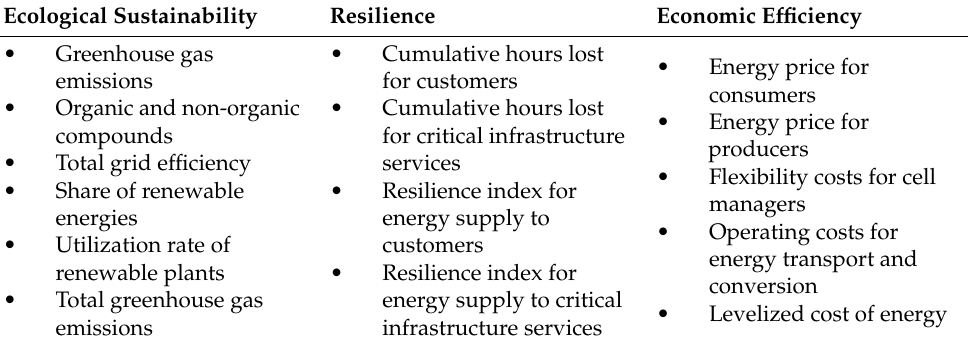
Table 2. Evaluation